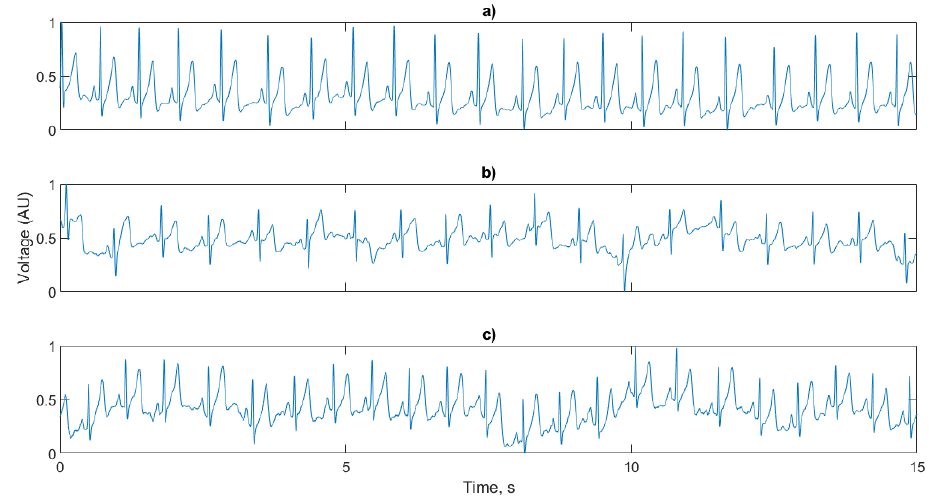
Figure 13. 15 s segments of a human signal ECG signal recorded with ( a ) baseline copper electrodes; ( b ) conductive polymer ink; ( c ) conductive textile fabric.